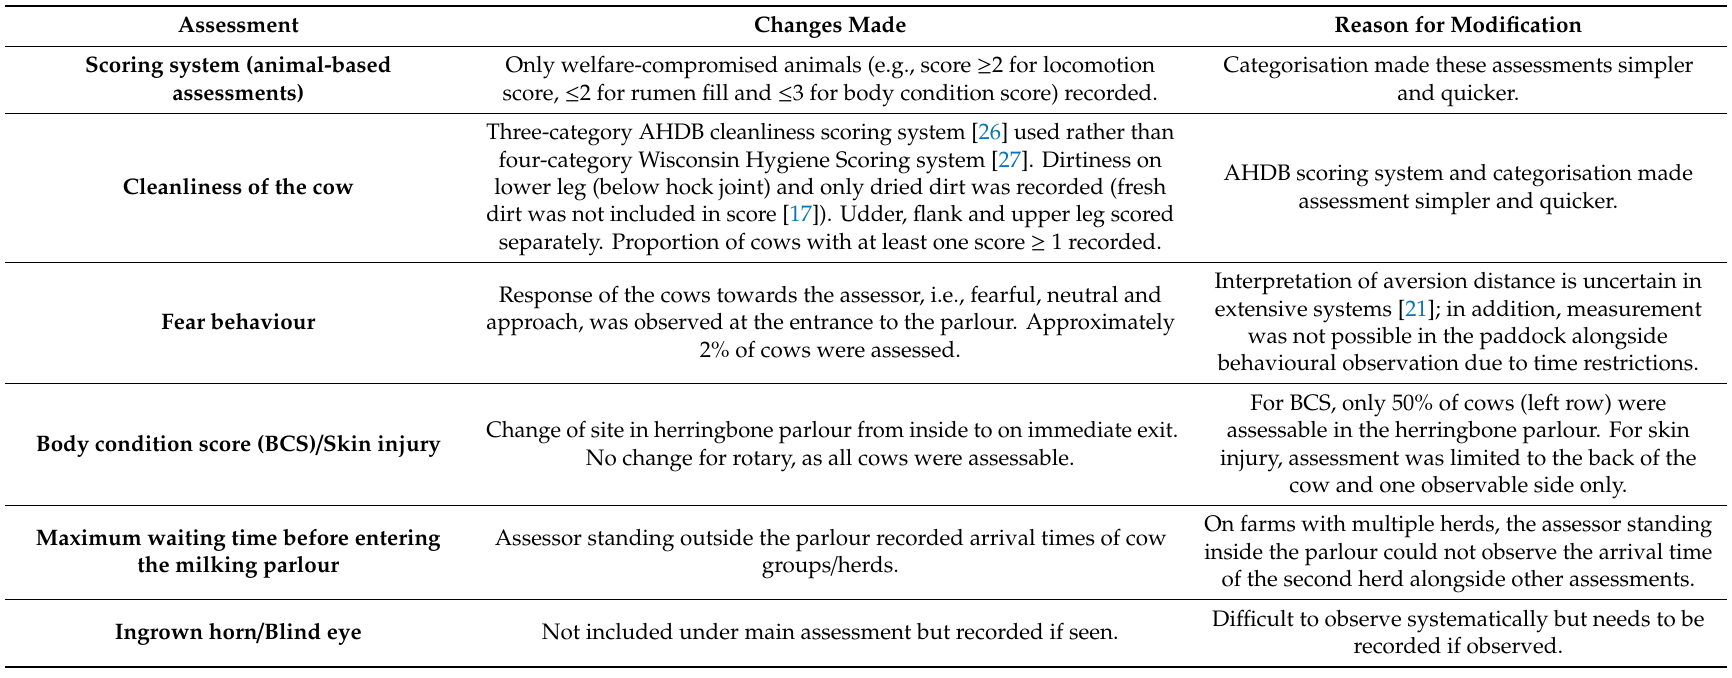
Table 3. Final proposed assessment protocol for assessing welfare of pasture-based dairy cattle on New Zealand farms with respective site of assessment.